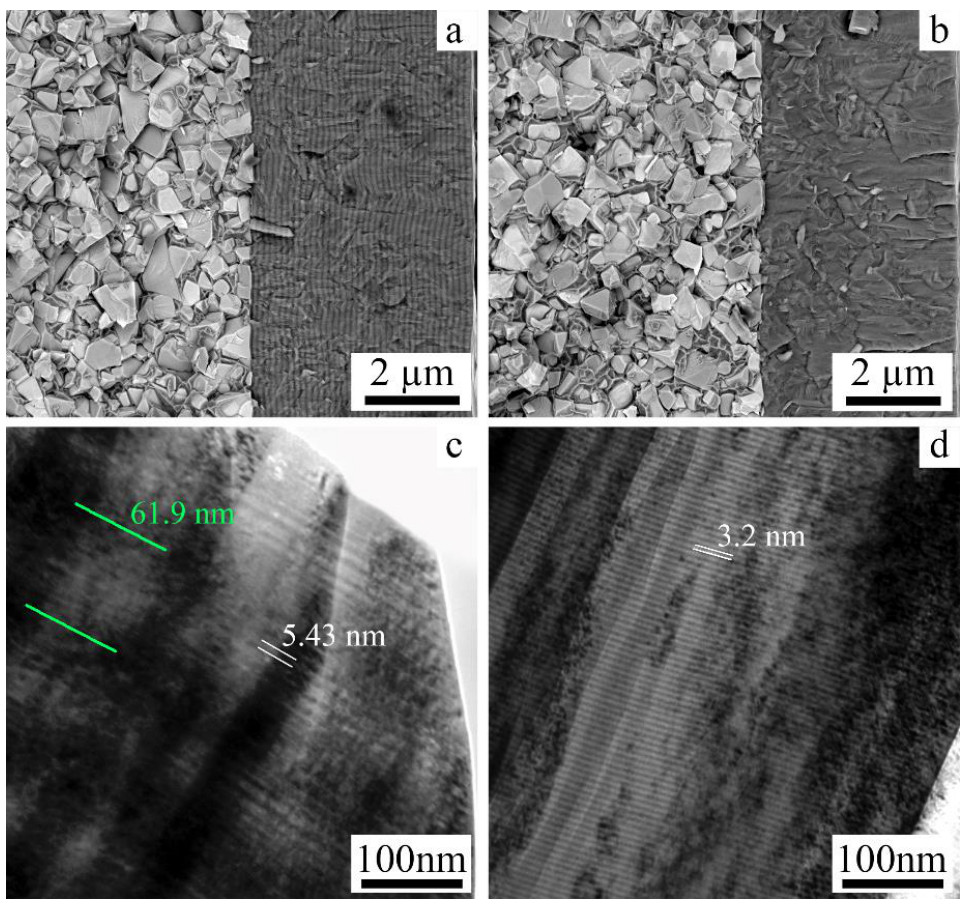
Figure 1. SEM ( a , b ) and TEM ( c , d ) cross-section views of the 0.5 RPM ( a , c ) and 8 RPM ( b , d ) multilayer coatings.